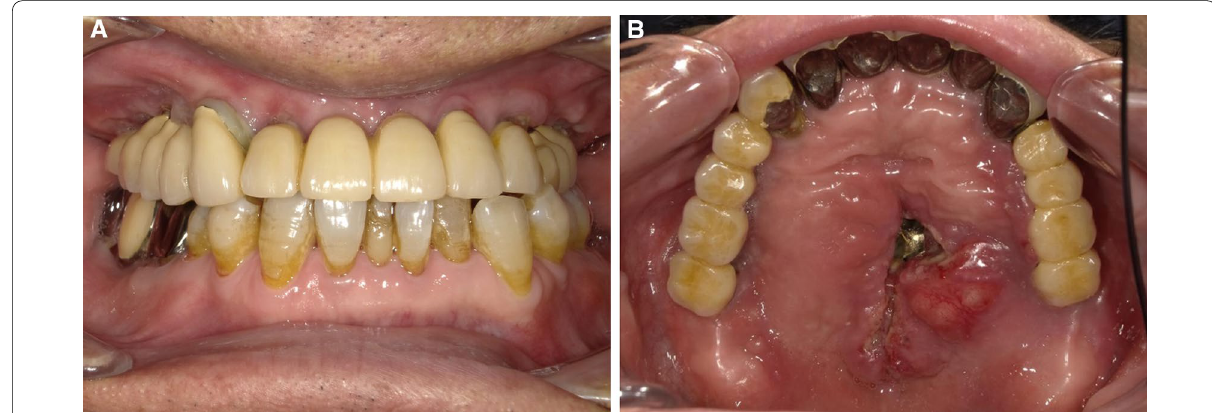
Fig. 1 Frontal view of an intraoral photograph showing a molar prosthesis attached to the metal framework ( A ). Palatal view of an intraoral photograph showing the metal framework exposed through the fistula with an undermined ulcer ( B